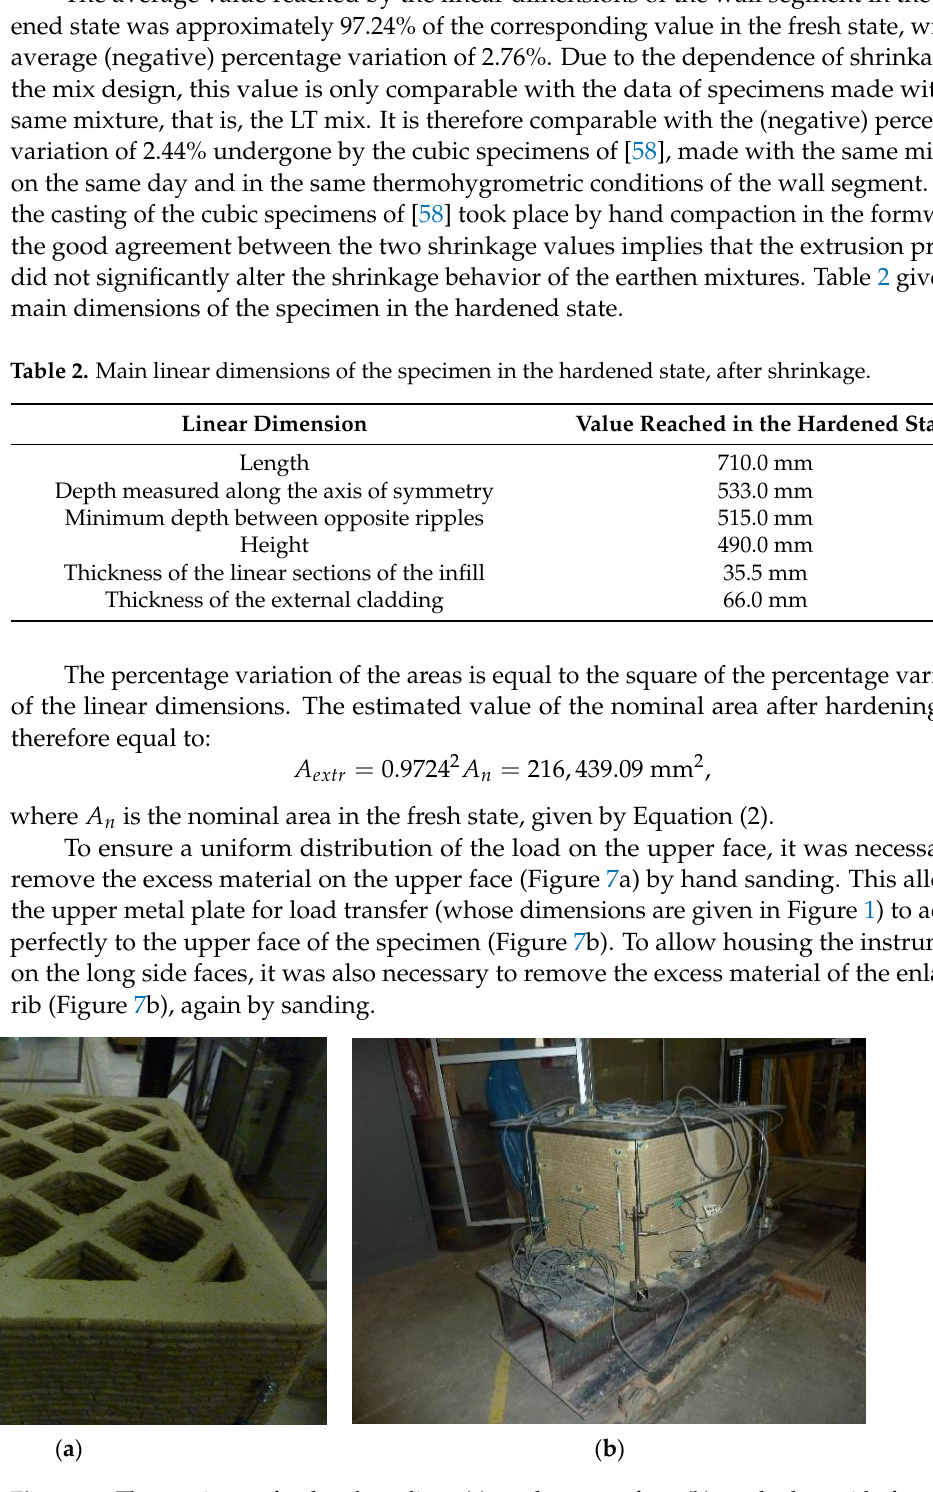
Figure 7. The specimen after hand sanding: ( a ) on the upper face; ( b ) on the long side face facing the operator.